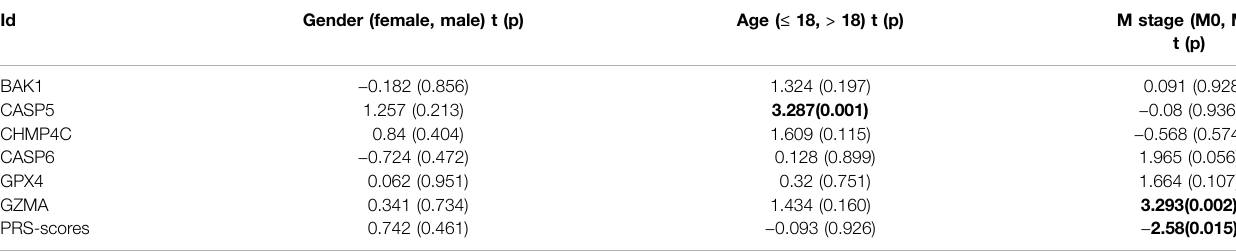
TABLE 1 | The relationship between PRS-scores and clinical characteristics.